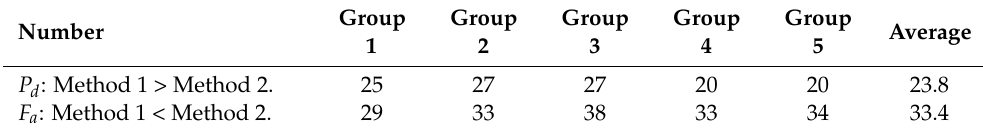
Table 7. Comparison of the performance of Method 1 and Method